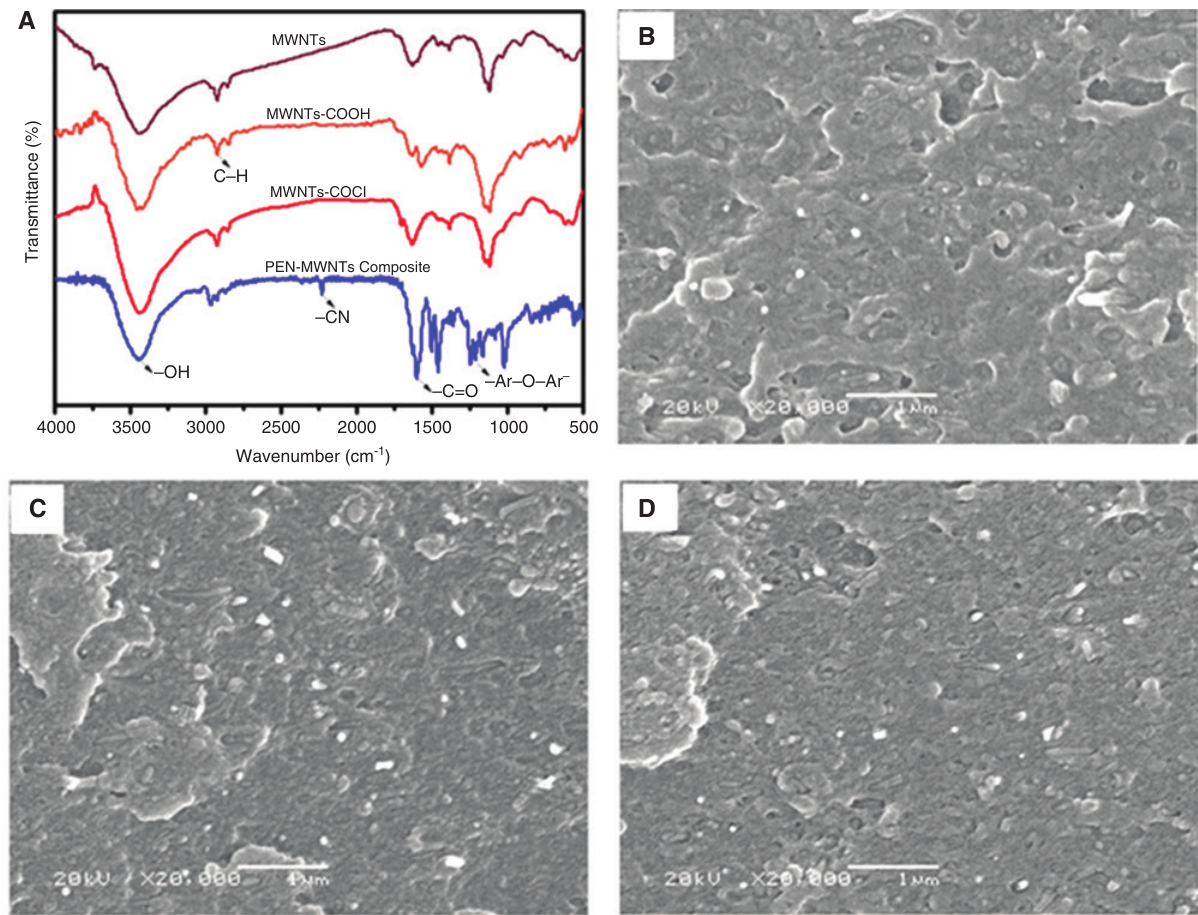
Figure 2: Characterization of MWNTs, MWNTs-COOH, MWNTs-COCl, and PEN-MWNT films with 4 wt% MWNTs-COCl content: (A) FTIR spectra. SEM images of PEN-MWNT films depending on the MWNTs-COCl content: (B) 4 wt%, (C) 5 wt%, and (D) 6 wt%.